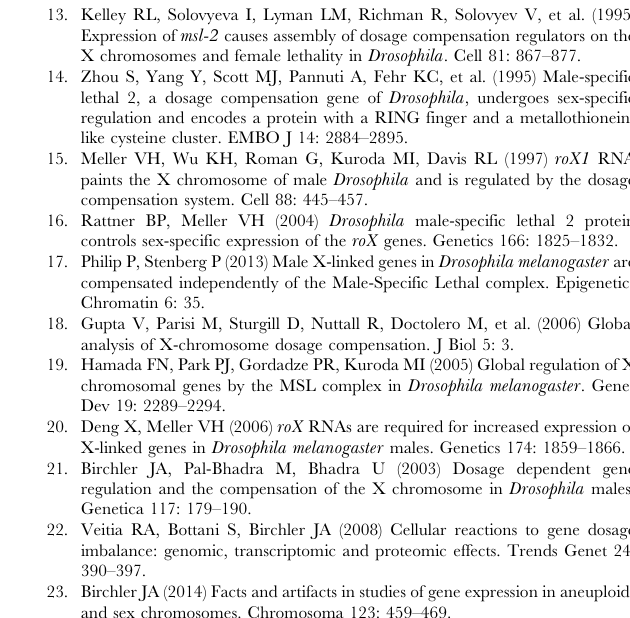
S1 Figure H4K16ac and MSL3 immunostaining on polytene chromosomes from roX mutant males, showing the 4 th chromo- some and chromocenter targeting. Note that H4K16ac on the 4 th